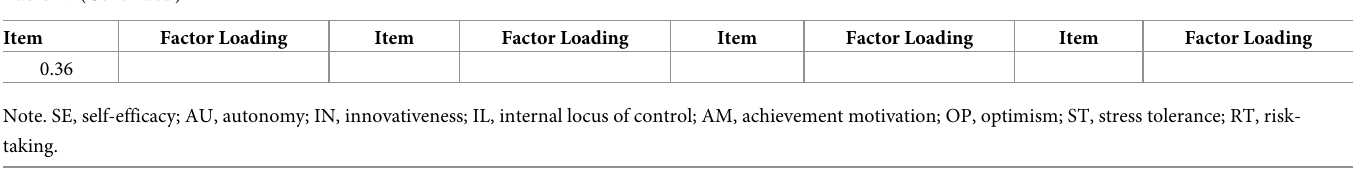
Table 3. Goodness-of-fit indices for measurement invariance of the BEPE-A (Bifactor model) across gender and age. χ 2 Df CFI TLI RMSEA (90% C.I)